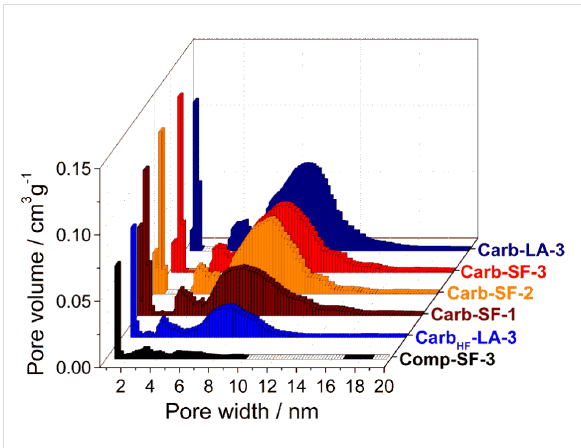
Figure 6: Volume histogram of the different samples calculated using a QSDFT-kernel for slit, cylindrical and spherical pores on the adsorp- tion